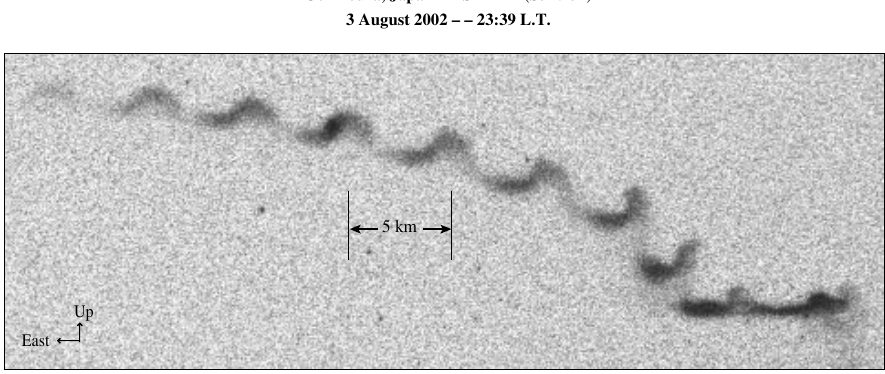
Fig. 15. Image (negative photograph) of the TMA chemical release from the Kochi observing site showing the billowing structure in the neutral wind (Larsen et al.,